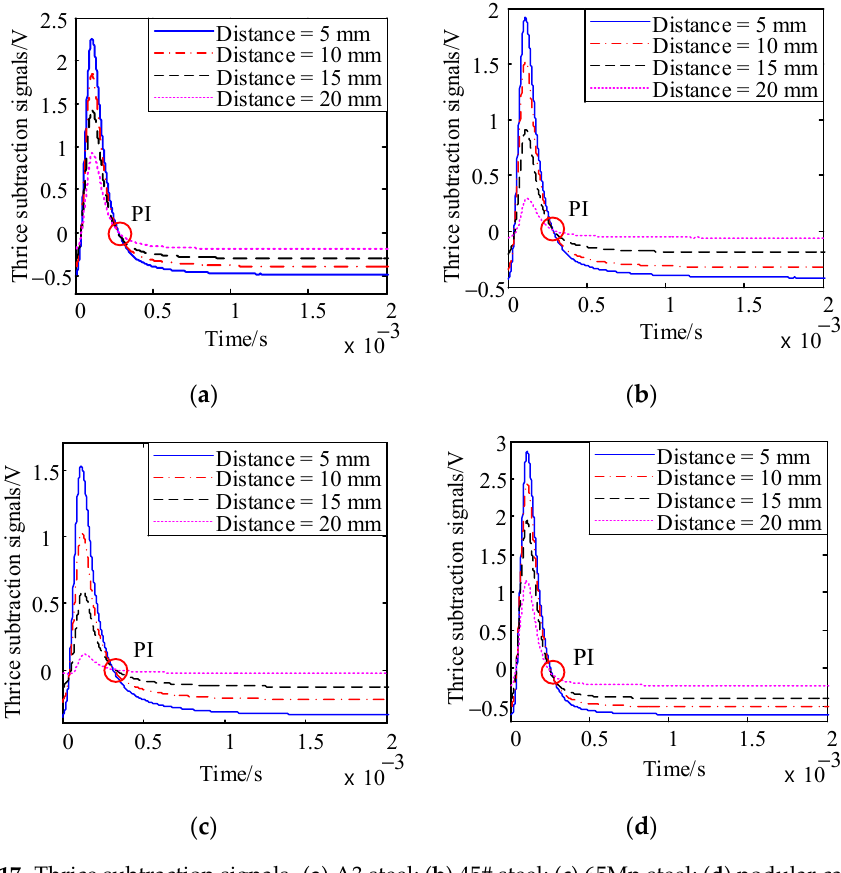
Figure 17. Thrice subtraction signals. ( a ) A3 steel; ( b ) 45# steel; ( c ) 65Mn steel; ( d ) nodular cast iron.